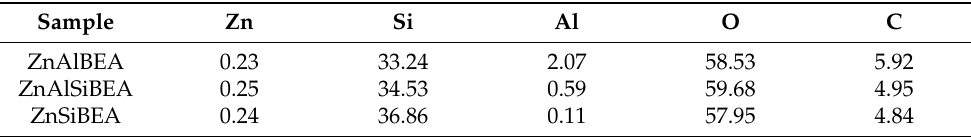
Table 2. Surface elemental composition of Zn-BEA zeolites (at. %).